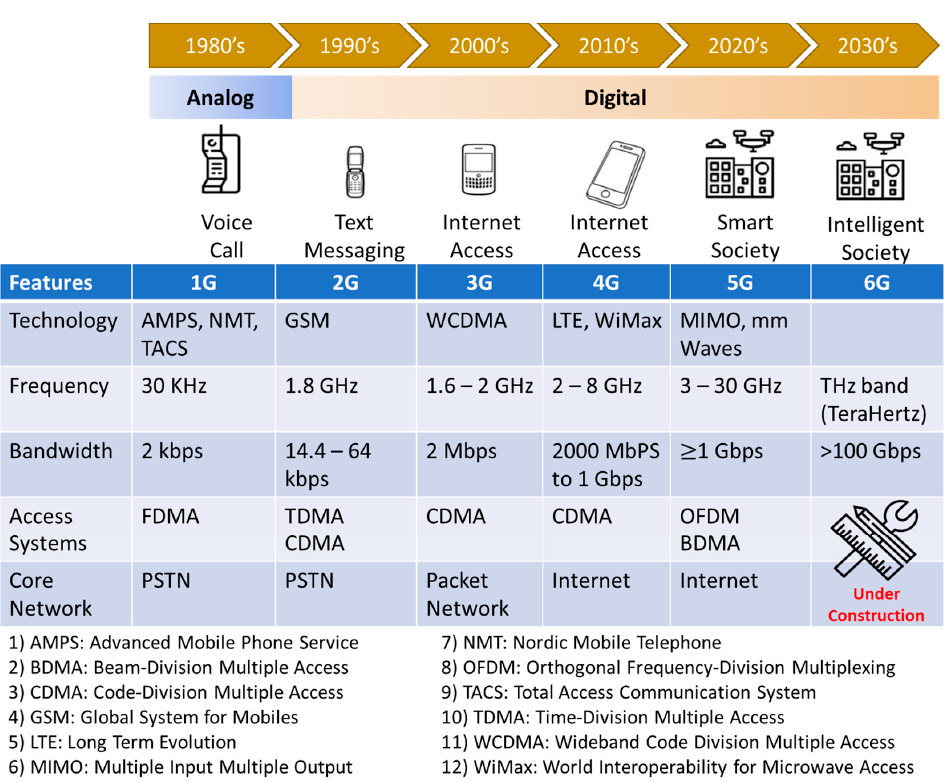
Figure 1. Evolution of mobile network technologies.